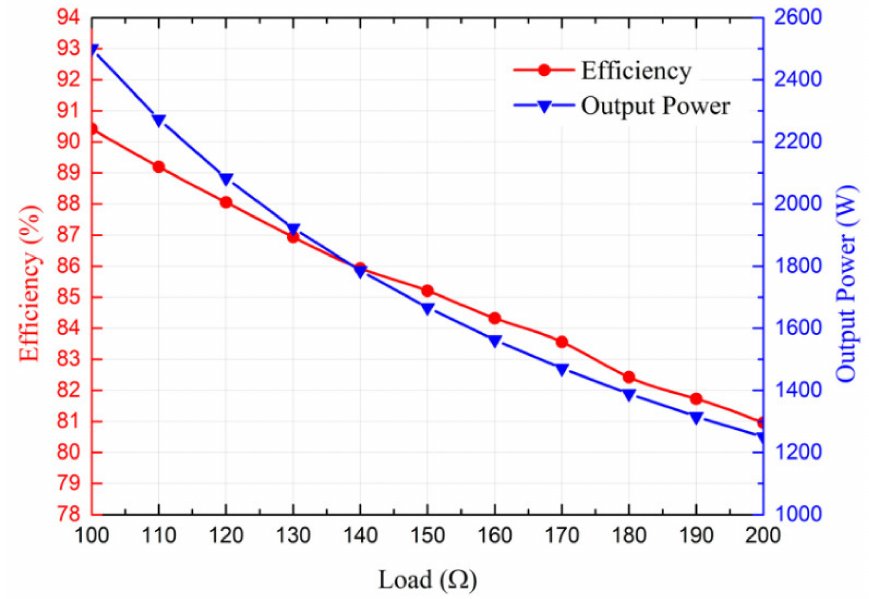
Figure 17. The measured values of overall dc-dc efficiency and the output power at different loads.